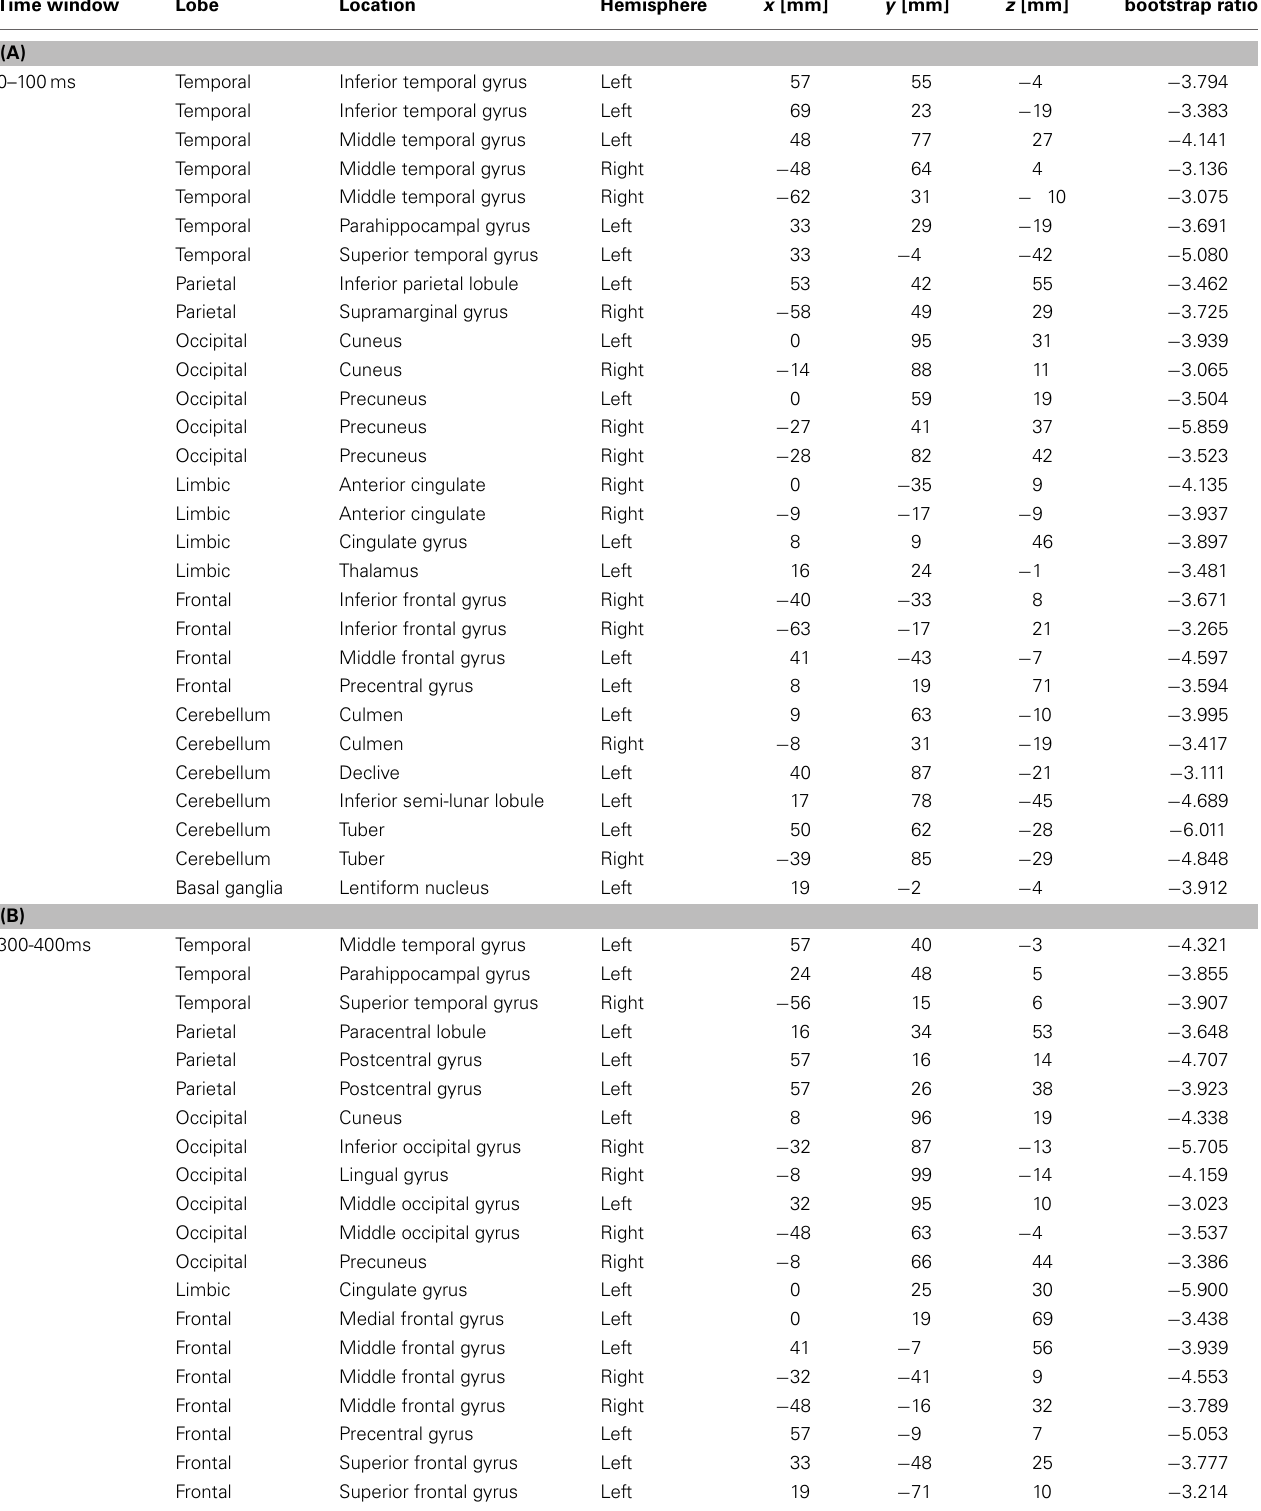
Table 2 | Brain locations associated with the downbeat contrast in the time window in the 0–100ms, and 300–400ms, expressed in Talairach brain atlas coordinate system (x:RL[mm], y:AP[mm], z:IS[mm]). Time